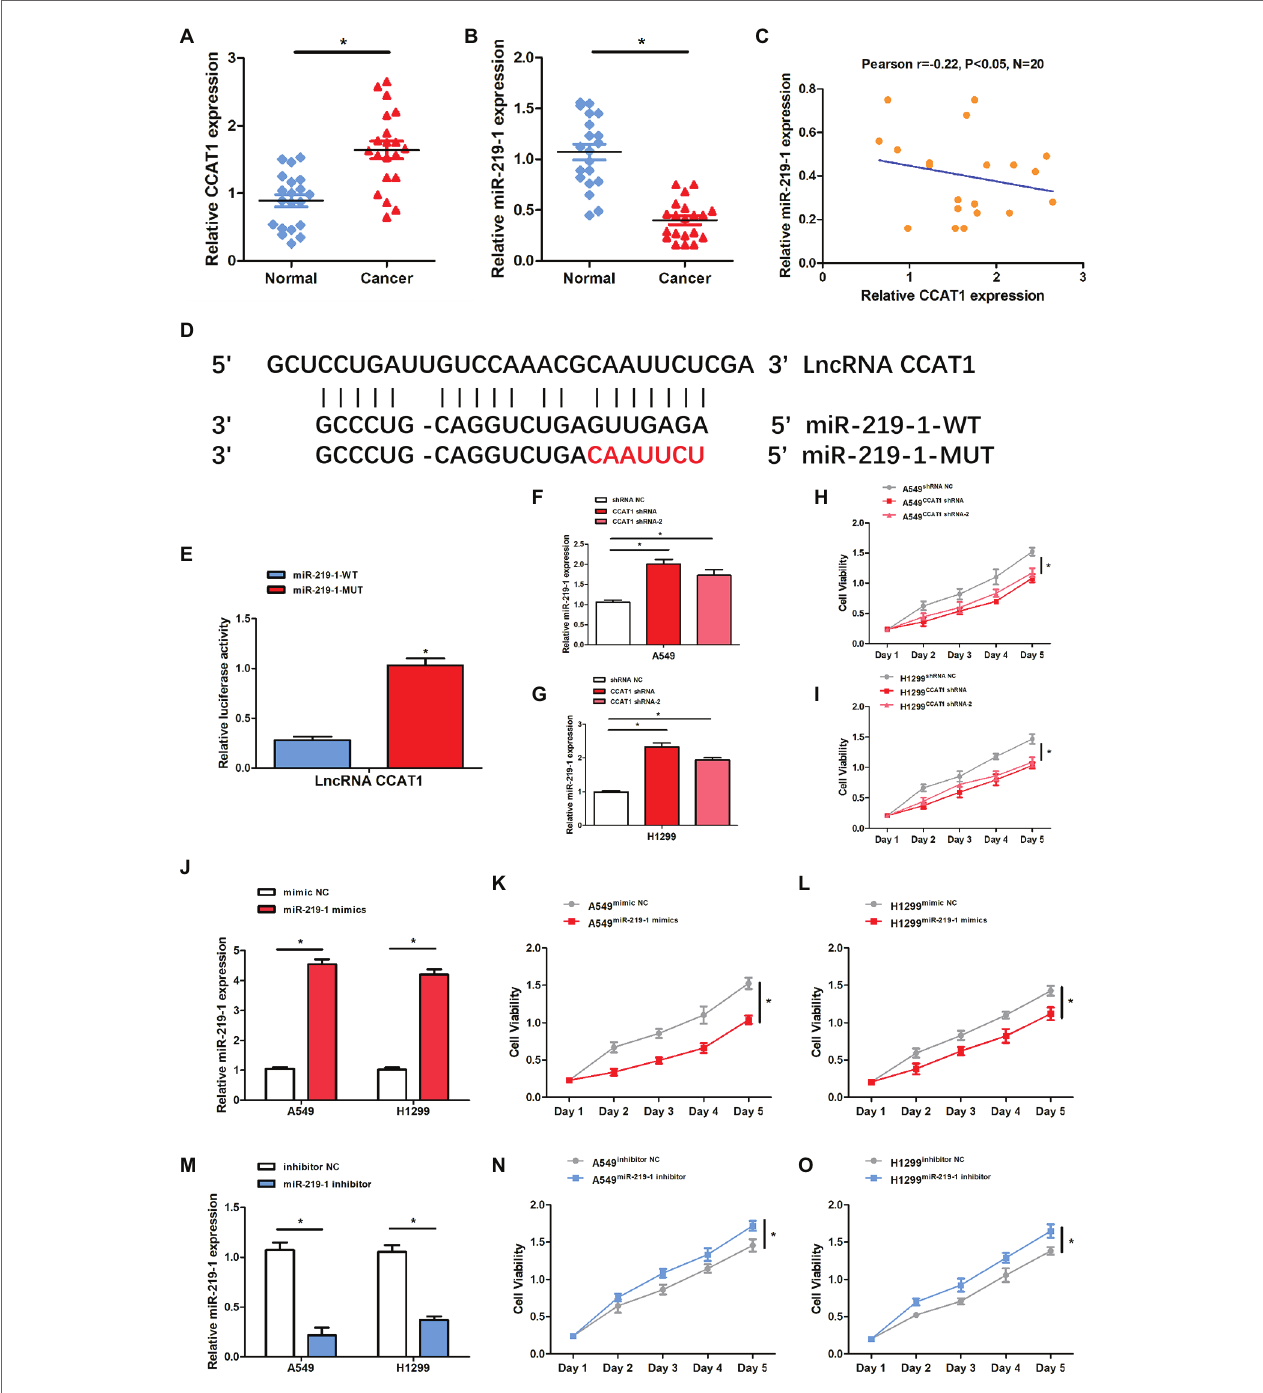
FIGURE 1 | The expression of colon cancer-associated transcript-1(CCAT1) was negatively related to the miR-219-1 expression. (A) Relative CCAT1 expression in human lung adenocarcinoma (LAD) and adjacent non-tumor tissues. (B) Relative miR-219-1 expression in human LAD and adjacent normal tissues. (C) An inverse correlation between CCAT1 and miR-219-1 expressions in LAD tissue samples. (D) Bioinformatics analysis was performed to identify miR-219-1 binding sites in CCAT1. (E) A luciferase reporter assay was used to examine the relationship between CCAT1 and miR-219-1. (F,G) Relative miR-219-1 expression in A549 and H1299 cells transfected with CCAT1 shRNA and CCAT1 shRNA-2. (H,I) Cell viability of A549 and H1299 transfected with CCAT1 shRNA and CCAT1 shRNA-2. (J) Relative miR-219-1 expression in A549 and H1299 transfected with the miR-219-1 mimic and NC. (K,L) Cell viability of A549 and H1299 transfected with the miR-219-1 mimic and NC. (M) Relative miR-219-1 expression in A549 and H1299 transfected with the miR-219-1 inhibitor and NC. (N,O) Cell viability of A549 and H1299 transfected with the miR-219-1 inhibitor and NC. Data are shown as means ± SD. * p <